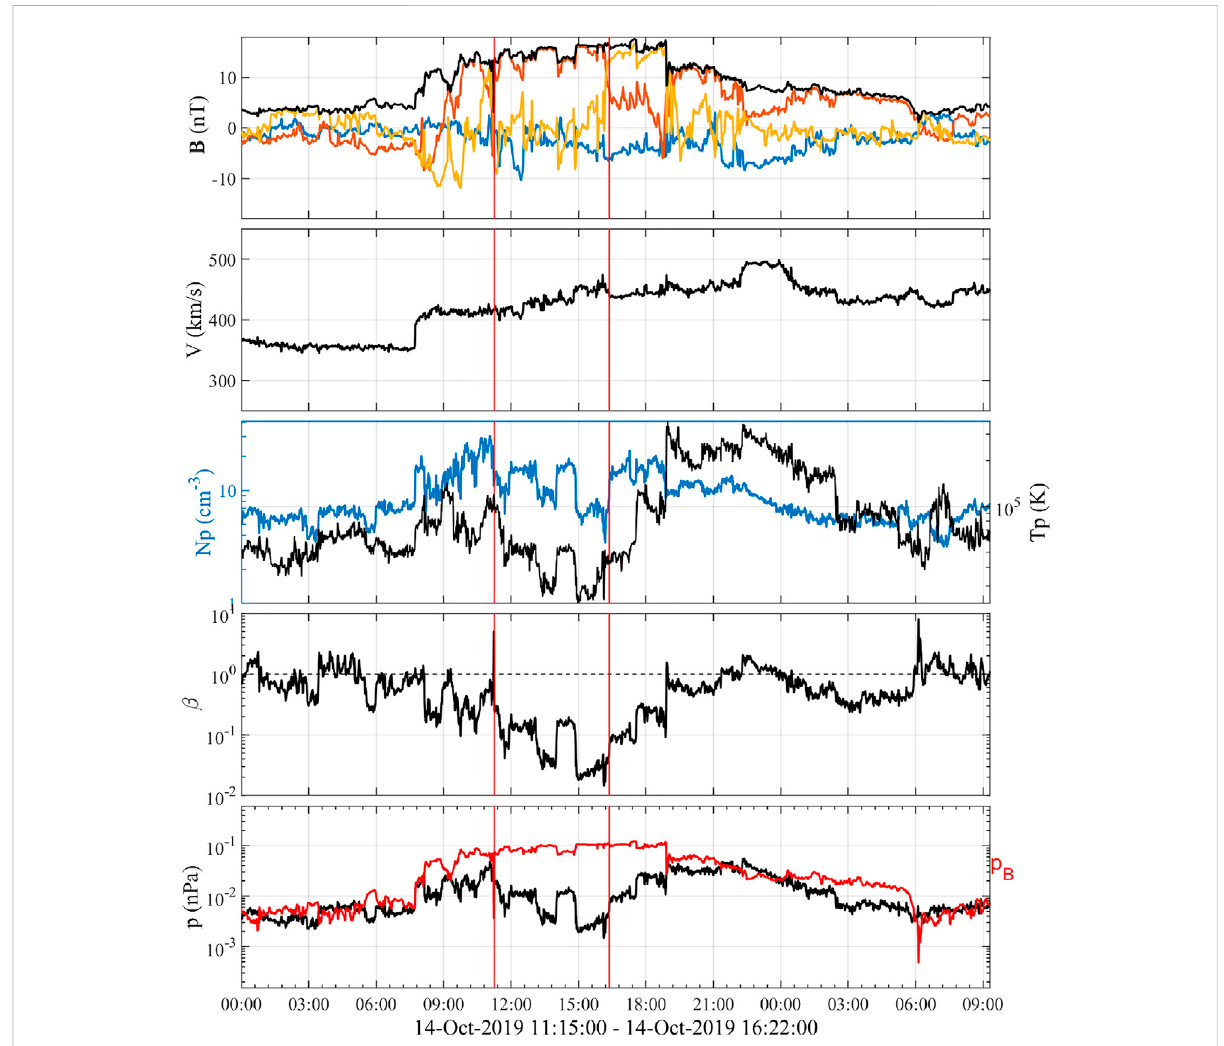
FIGURE 2 Time-series measurements from the STA spacecraft starting on 14 October 2019. From the top to bottom panels are: the magnetic fi eld components in the Radial (blue), Tangential (red), and Normal (gold) coordinates and magnitude (black), the solar wind speed, the proton number density (left axis) and temperature (right axis), the proton β , and the proton pressure and total magnetic pressure p B . The vertical lines mark the interval chosen for analysis, as given beneath the bottom panel in